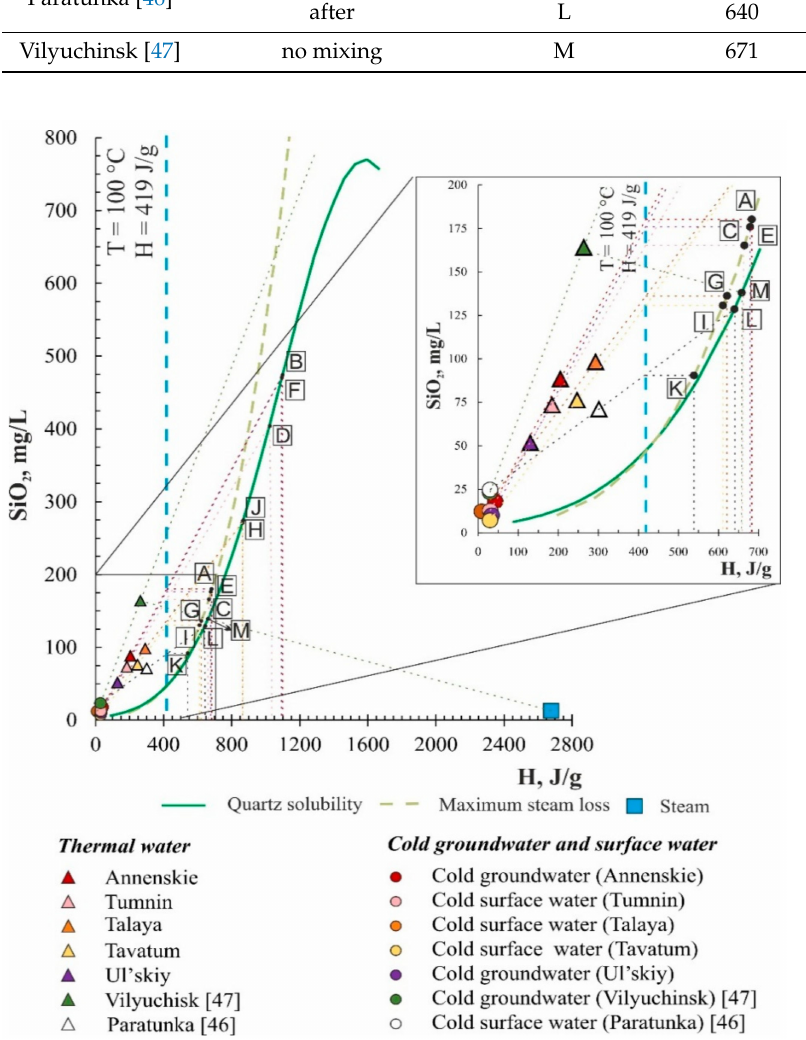
Figure 5. Silica-enthalpy mixing model for Okhotsk Sea Coast thermal